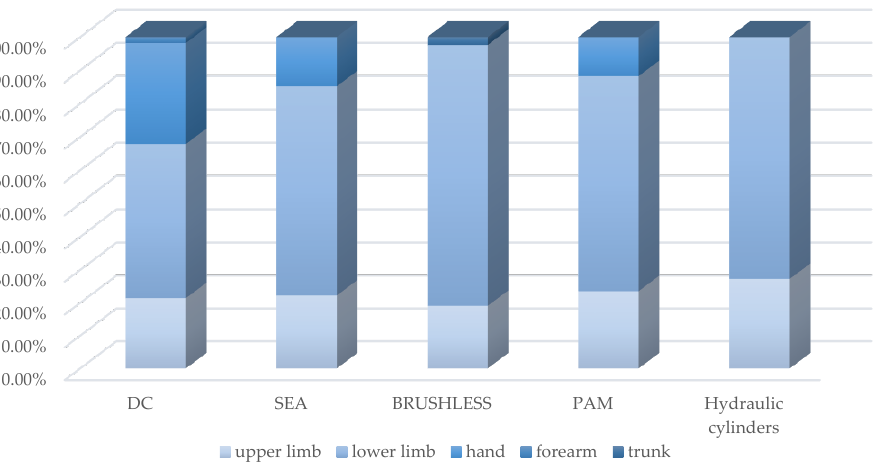
Figure 21. The distribution of the anatomical district to which the exoskeleton is devoted for the most used actuator types. For all the actuator types, included in the histogram LLE is the dominant application with a lower percentage (46%) for brushed DCs, for which HED have also a significant weight (30%).